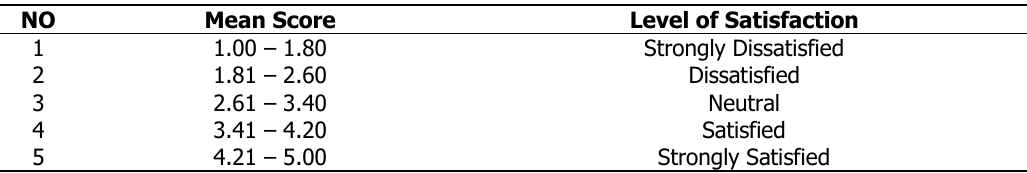
Table 2. Criteria for Understanding the Mean Score